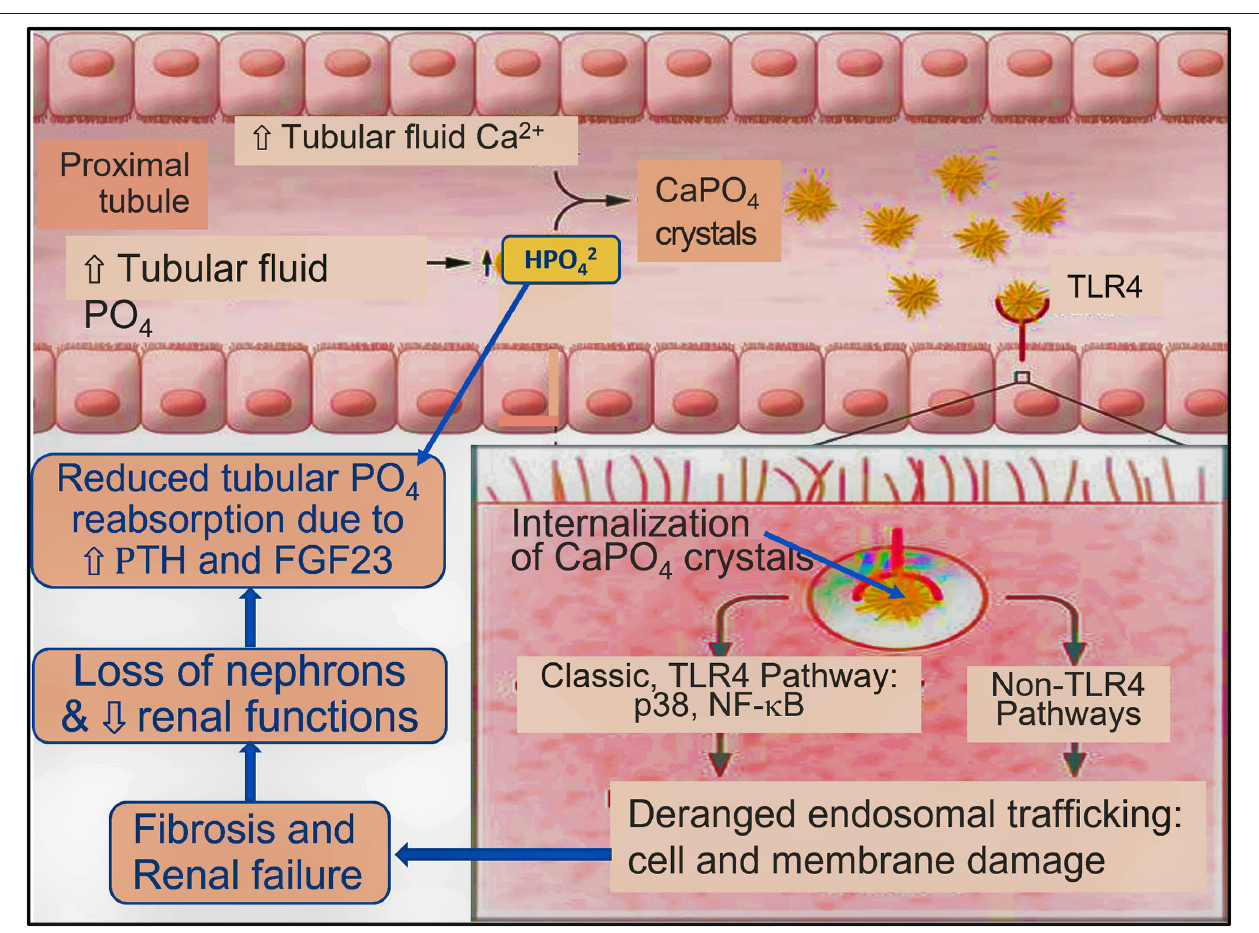
FIGURE 5 | Postulated generic model for renal tubular crystalloid-nephropathy and progression of CKD [concept by Shiizaki et al. (2021) and modified from Moe (2021)]. Increased tubular fluid PO 4 reacts with Ca 2 + to form CaPO 4 crystals and transforms to hydroxyapatite.